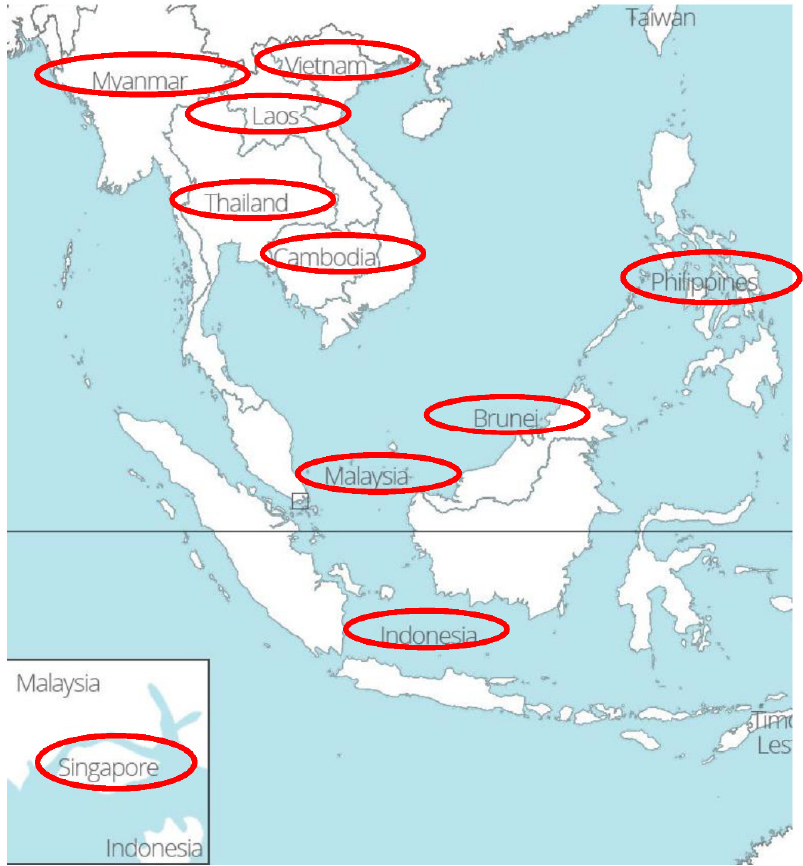
Figure 2. List of countries (circled in red) reviewed for coastal vulnerability assessment within Southeast Asia. Southeast